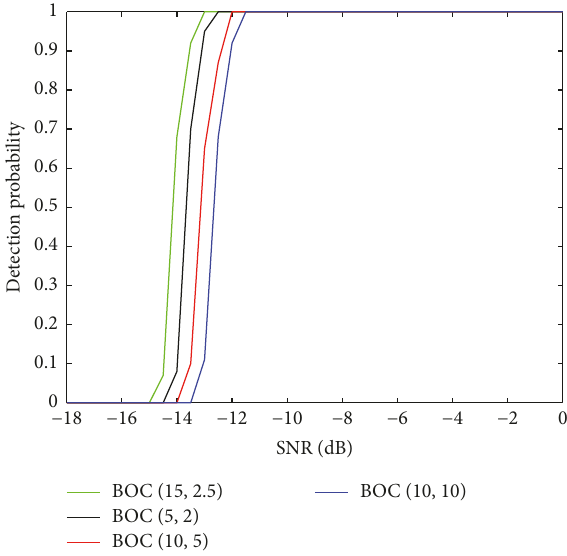
Figure 10: Detection probability for different values of 𝑓 𝑐 and 𝑓 𝑠 .